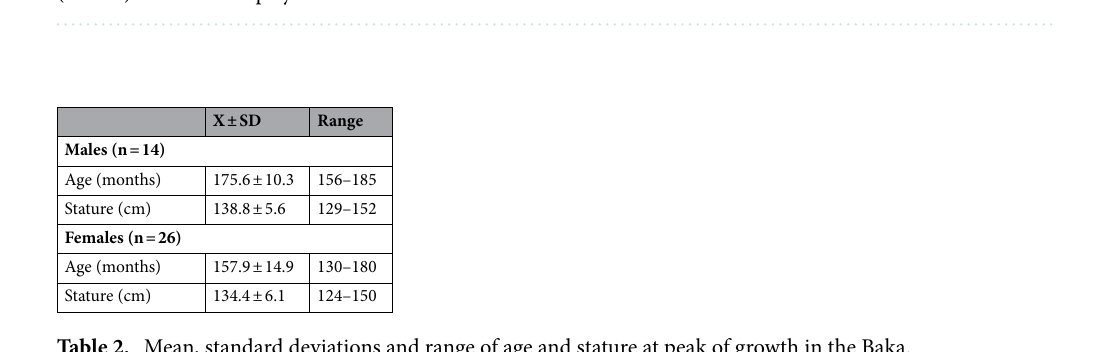
Table 1. Mean, standard deviations and range of age, stature and pubertal stage (male) or age at menarche (female) in basketball players.